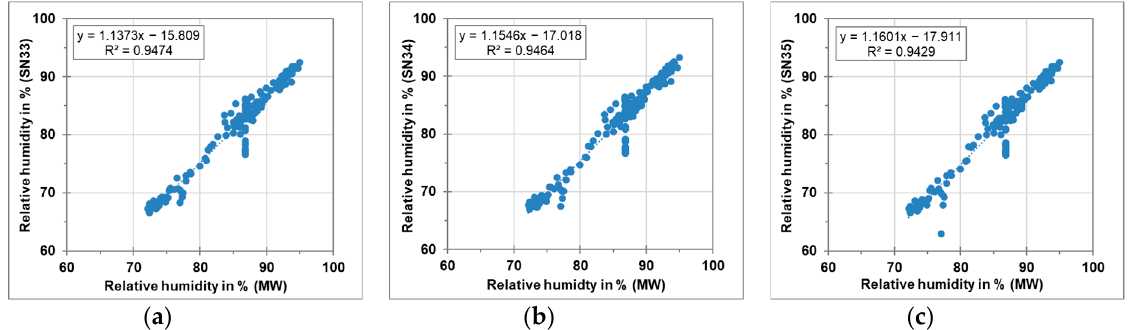
Figure 20. Comparison of relative humidity sensors at stationary monitoring station and HOBO sensors ( a ) SN33 ( b ) SN34 ( c ) SN35.